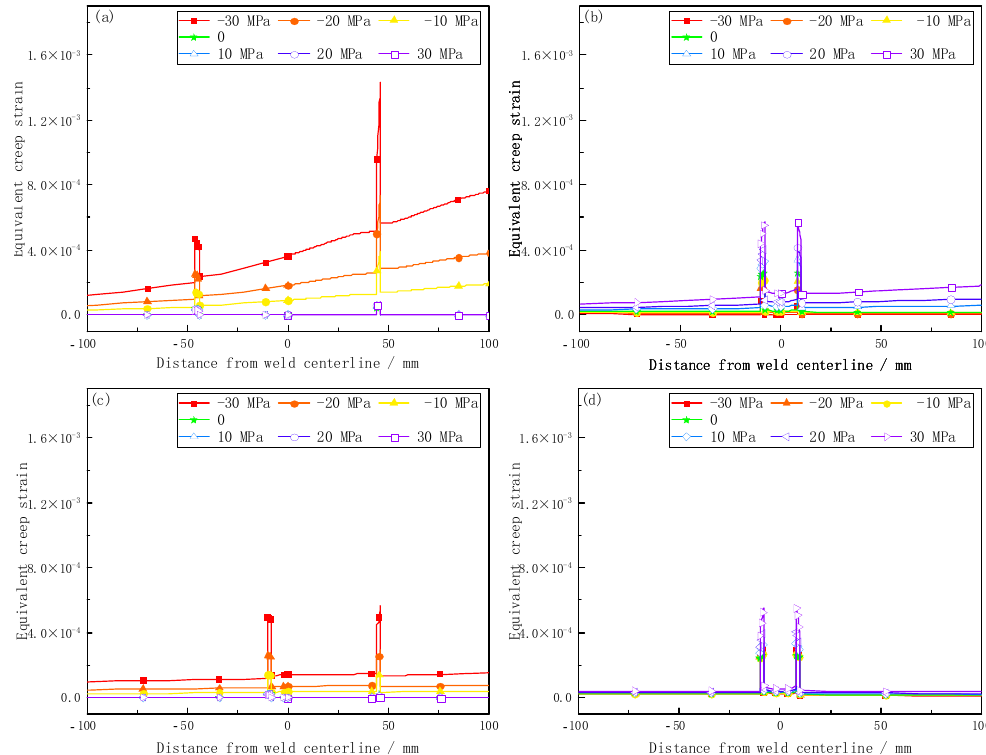
Figure 5. Effect of axial structural induced stress on equivalent creep strain of pipe to elbow welds: ( a ) 12:00 position of outer surface, ( b ) 12:00 position of inner surface, ( c ) 6:00 position of outer surface, ( d ) 6:00 position of inner